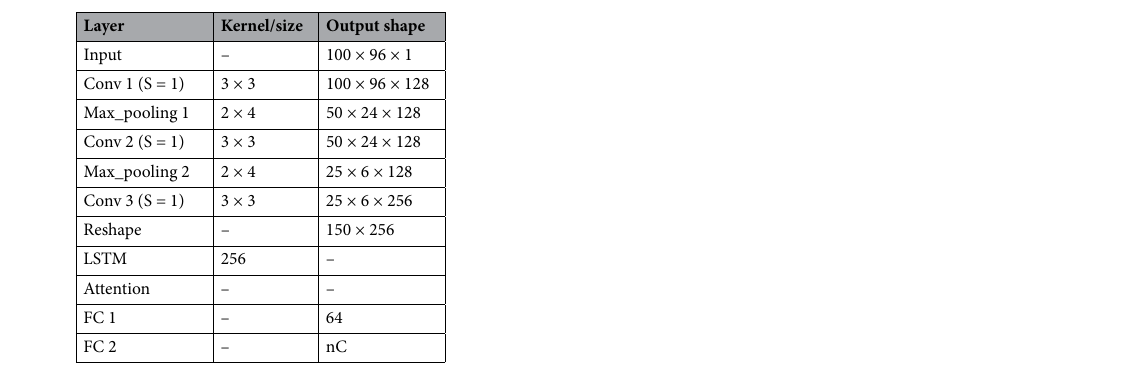
Table 1. The layers of the proposed model.